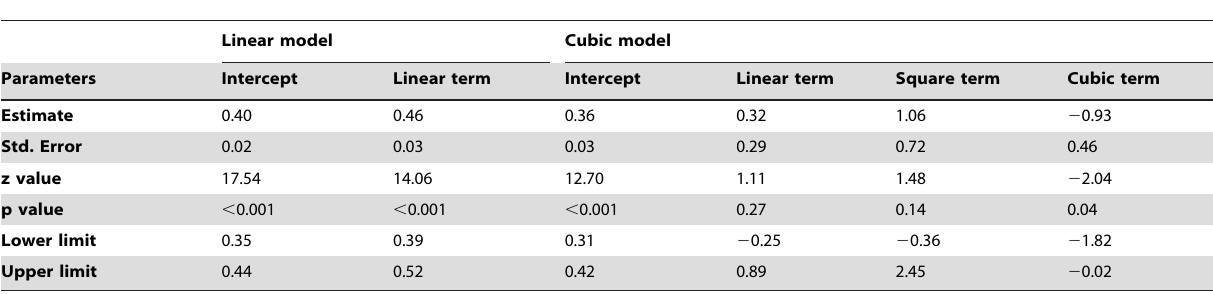
Table 3. Estimated parameters for the linear and cubic models.